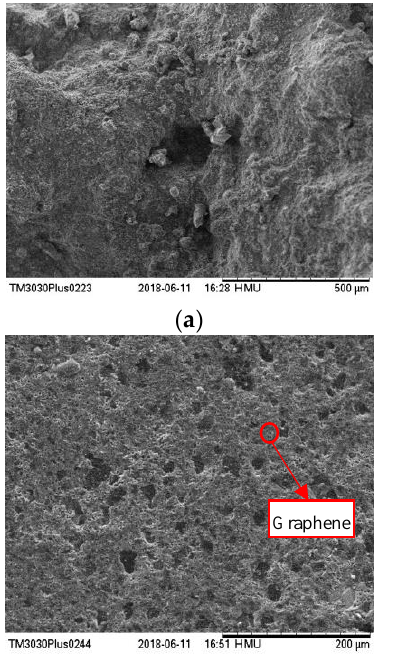
( c ) Figure 2. Rheometer used in the measurement. ( a ) MCR 502, ( b ) geometry of the rheometer, parallel plate, ( c ) schematic of loaded sample. Table 1. Viscosity measurements of salts and nanocomposites in the present study. Material Type